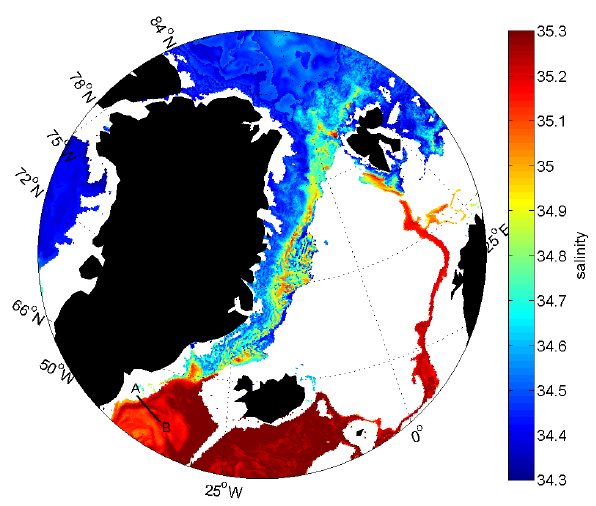
Fig. 14. Time-evolution of passive tracer, instantaneously released on 20 th December 2003 across section CD. Tracer was initialised on grid cells with σ θ > 27 . 6. Colour bar indicates vertically integrated tracer concentration in arbitrary units.